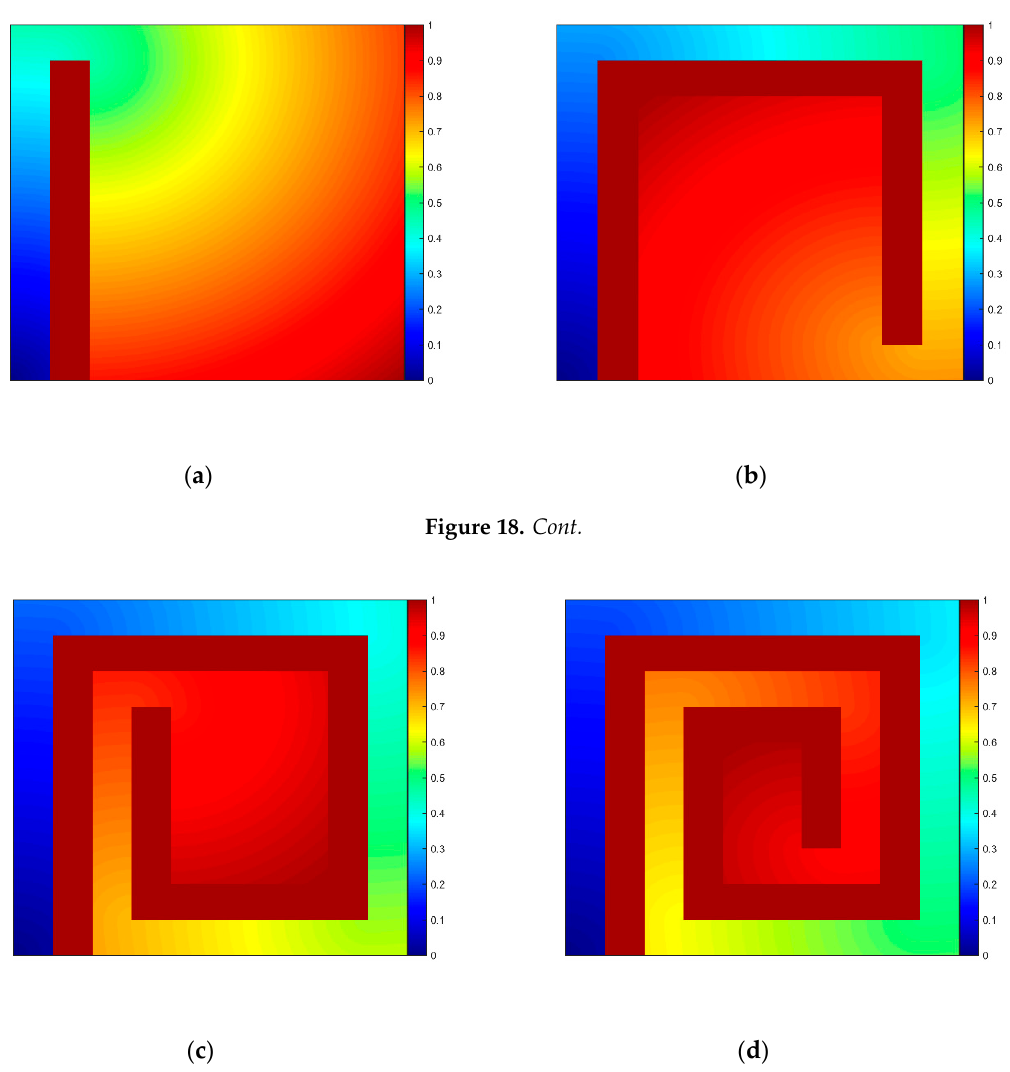
Figure 18. Example of the resulting time-of-arrival field applying the LSM to the environments with barriers: ( a ) 1 barrier; ( b ) 3 barriers; ( c ) 5 barriers; ( d ) 7 barriers.